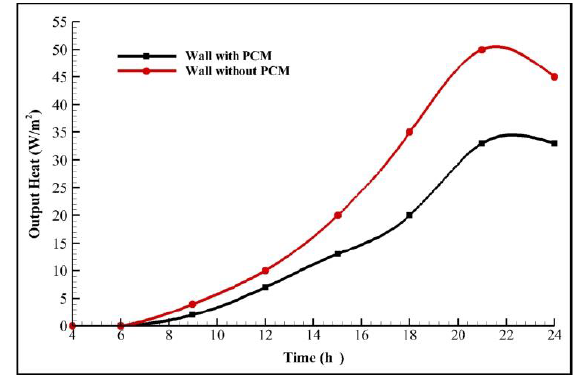
Figure 14. Amount of heat storage in the non ‐ PCM ‐ and PCM ‐ treated west walls.